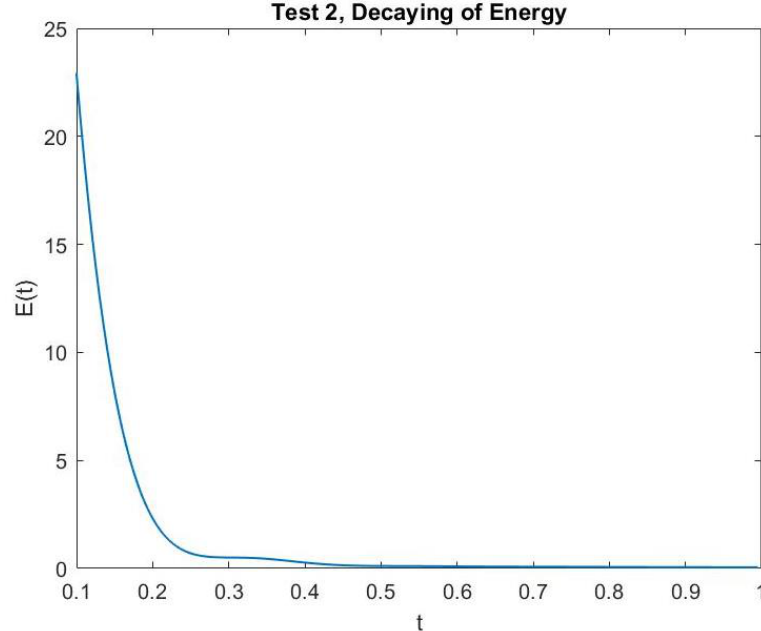
Figure 4. Test 2: The energy decay.